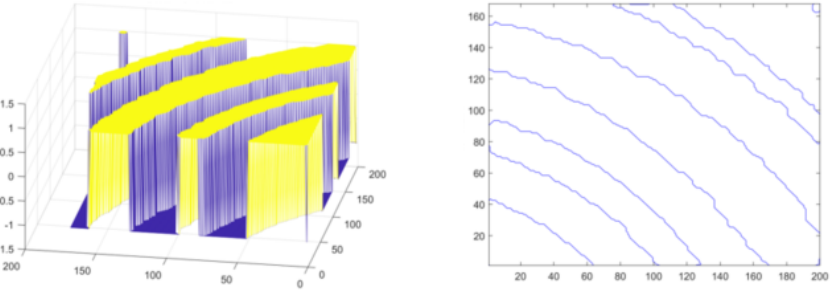
Figure 11. Evolution function and line extraction diagram after